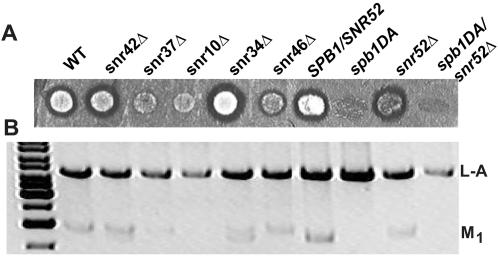
Many of the rRNA base modification mutants have M1 virus propagation defects.Yeast rRNA modification mutants were tested for their ability to maintain the L-A and M1 viruses. (A) Mutant and isogenic wild-type yeast strains were spotted onto YPAD plates, and allowed to grow at 30°C, and then replica plated to a seeded lawn of 5X47 indicator cells. Plates were incubated at room temperature for 3–5 days until a zone of inhibition was clearly visible for wild-type cells. (B) Total RNAs were extracted from mutant and isogenic wild-type yeast strains and digested with RNase A under high salt conditions. The resulting double-stranded RNA was separated on a 1% agarose gel and visualized with ethidium bromide. L-A and M1 dsRNAs are indicated. The image was inverted for clarity.